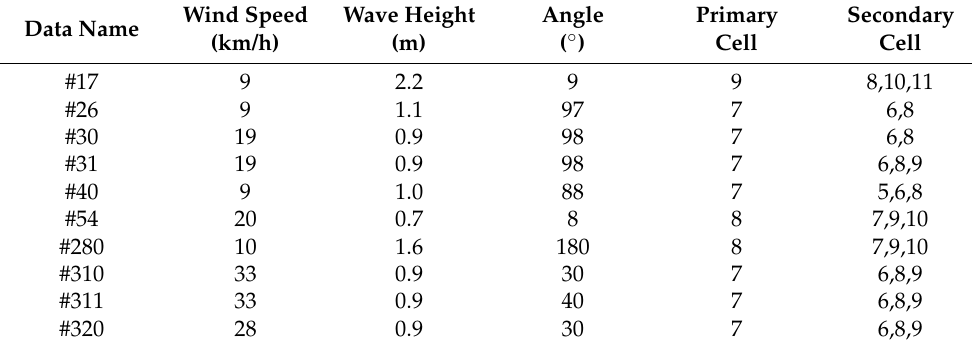
Table 2. Specific case description of IPIX radar